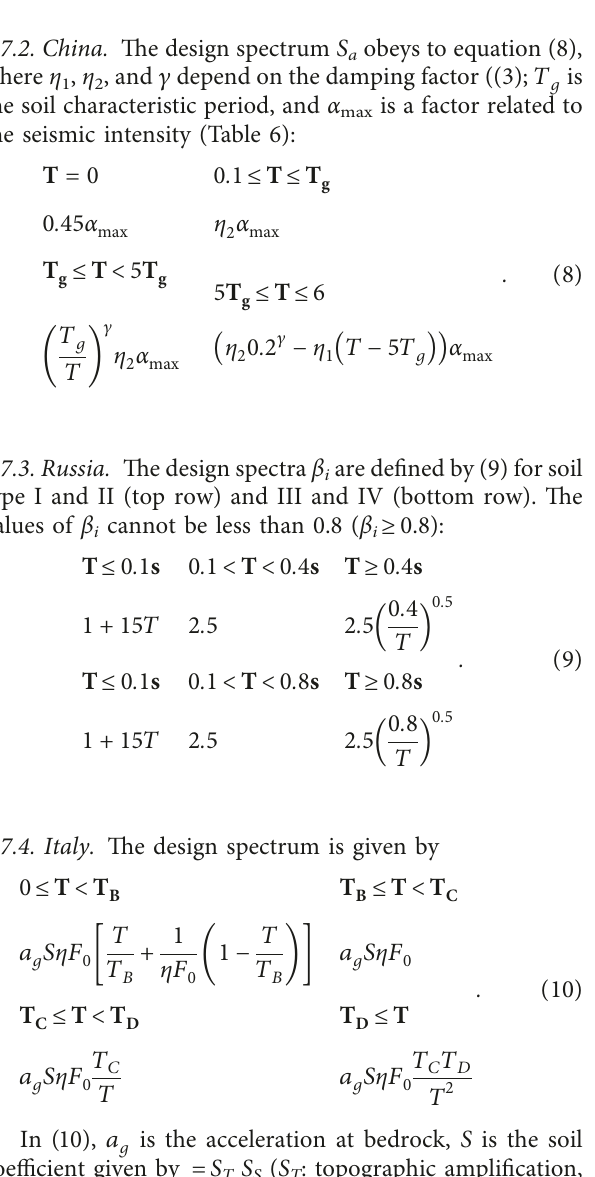
Figure 2: Reduction factor due to damping.